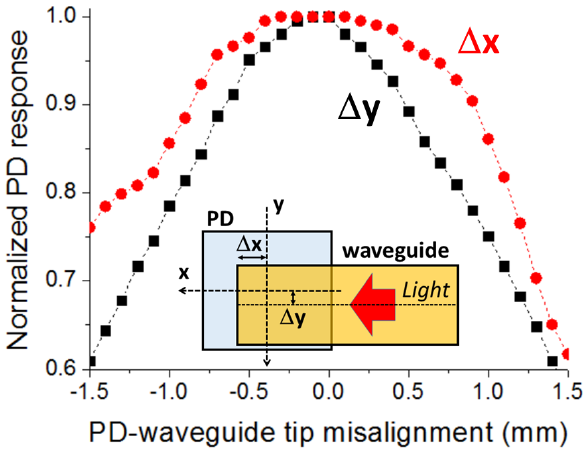
Figure 5. Normalized power detected by the photodetector (PD) as a function of the misalignment between the PD and the waveguide tip end along the x-axis and y-axis. ∆ x ( ∆ y) equals the PD center position minus the tip center position along the x-axis (y-axis) according to the inset diagram. Guided light propagation direction is +x-axis.